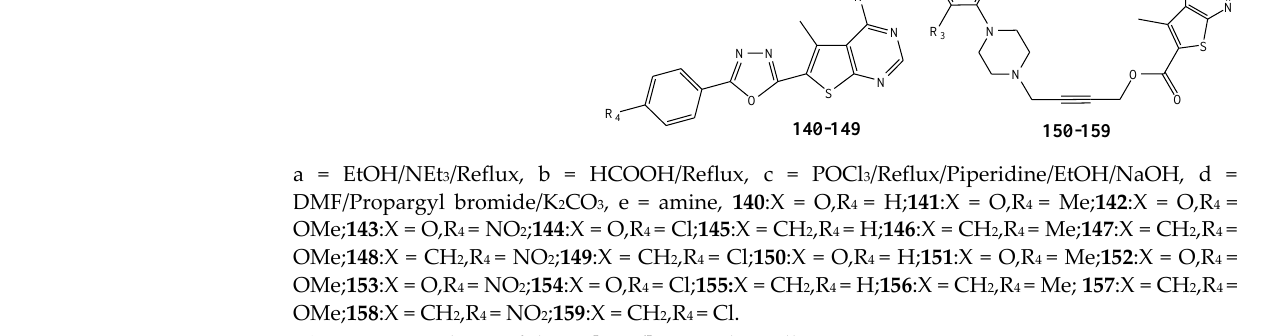
OMe; 158 :X = CH 2 ,R 4 = NO 2 ; 159 :X = CH 2 ,R 4 = Cl.